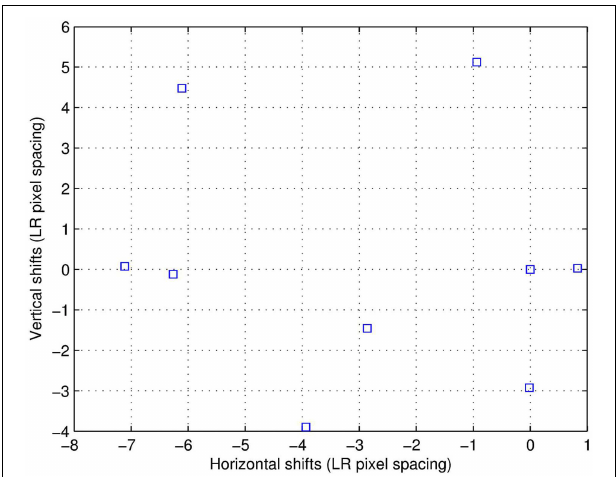
FIGURE 16 | The estimated shifts for the nine real LR frames (data set II).